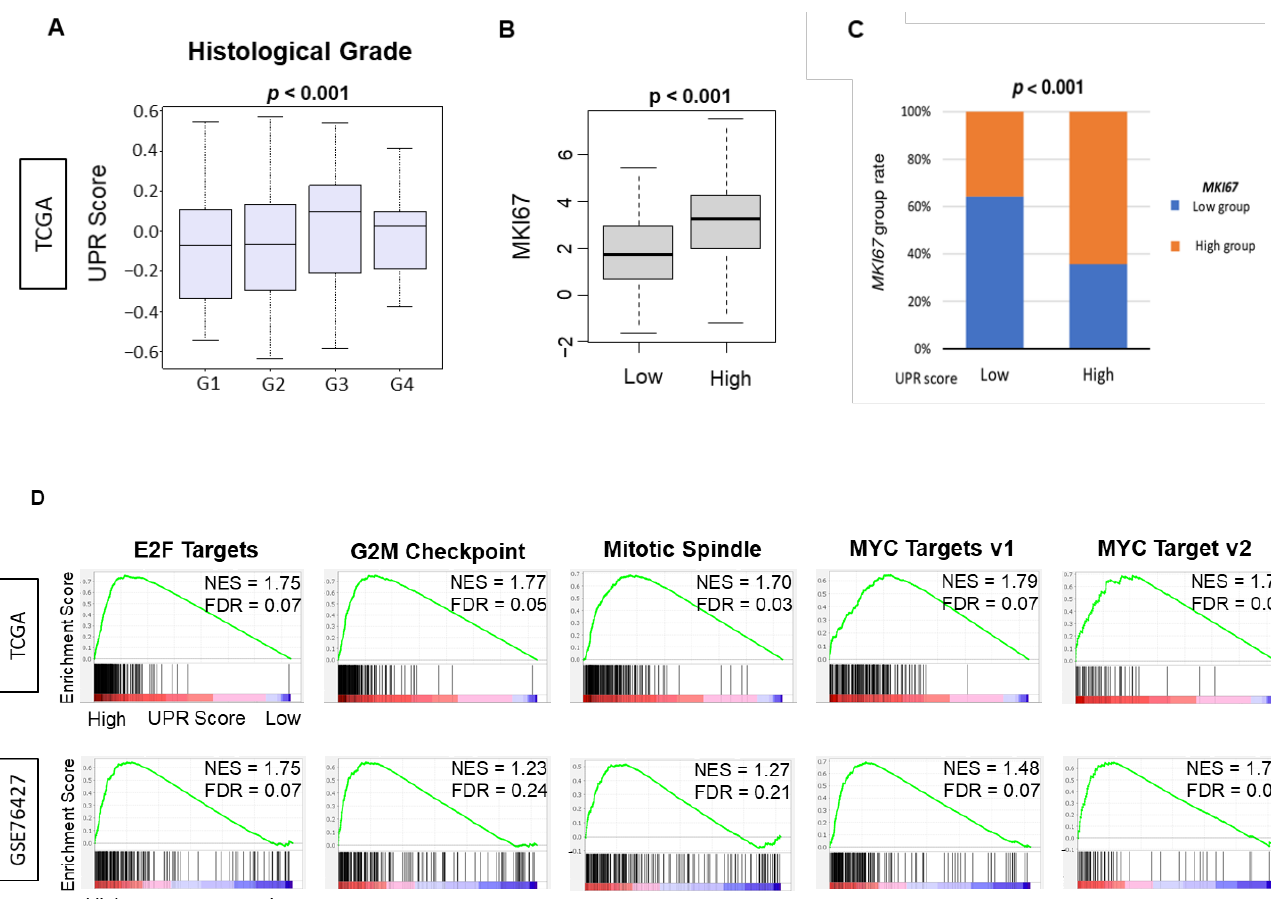
Figure 2. Association between Unfolded Protein Response and histological grade, MKI67 gene expression and cell proliferation-related gene sets. ( A ) Boxplot of the comparison of the unfolded protein response score with histological grade G1- 4 ( n = 53, 168, 121 and 11, respectively). The p -value was calculated using a Kruskal – Wallis test. ( B ) Boxplot of the comparison of the high vs. low unfolded protein response and the MKI67 gene expression (both n = 179) in the TCGA cohort. The p -value was calculated using the Mann – Whitney U test. ( C ) Bar plot of the comparison of low and high groups of the unfolded protein response score and MKI67 expression. The p - value was calculated using Fisher’s exact test. ( D ) Gene set enrichment analysis (GSEA) of the Hallmark gene sets by high vs. low unfolded protein response score of HCC in the GSE76427 and TCGA cohorts. Enrichment plots with the normalized enrichment score (NES) and false discovery rate (FDR) for proliferation-related gene sets. An FDR of 0.25 was used to determine statistical significance as recommended by the GSEA software (version 4.1.0, accessed on 27 February 2021) (Table S4).